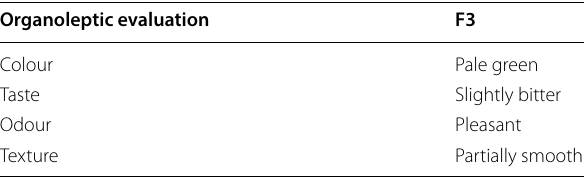
Table 6 Organoleptic analysis of tooth paste